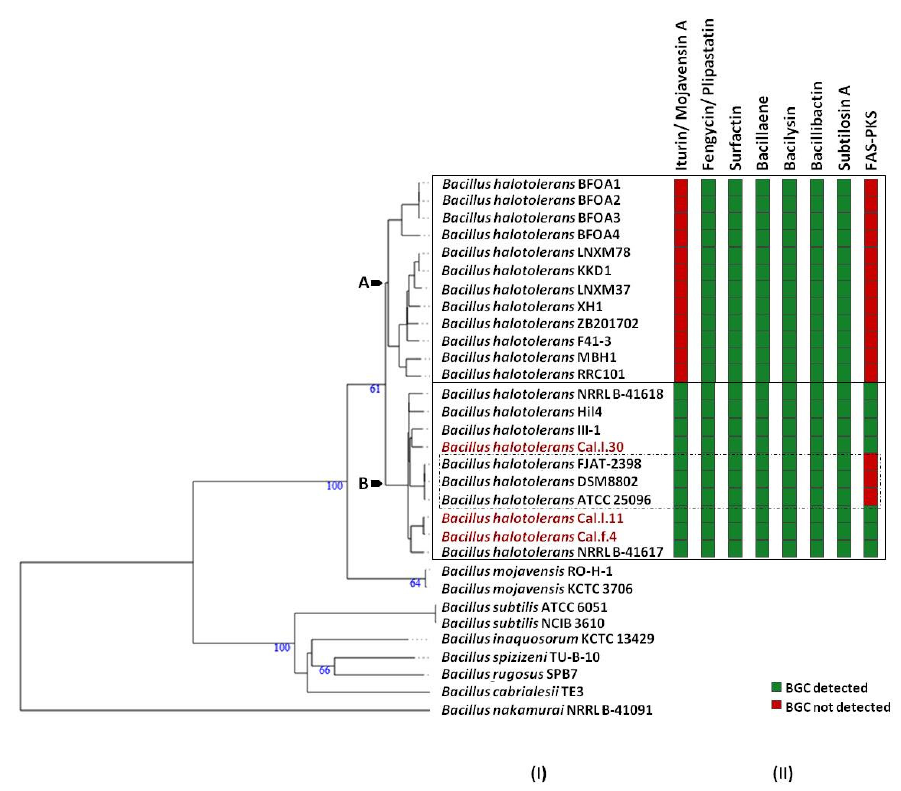
Figure 6. The secondary metabolic gene clusters evolution. ( I ) Whole genome phylogeny of B. halotolerans strains highlighting the endophytic bacterial strains Cal.l.30, Cal.f.4 and Cal.l.11. The numbers above branches are pseudo-bootstrap support values from 100 replications. Inferred clusters are for B. halotolerans strains harboring (Cluster B) or lacking (Cluster A) the iturin/ mojavensin A BGC. ( II ) Number and distribution heatmap of the secondary metabolite biosynthetic gene clusters (iturin/ mojavensin A, fengycin/ plipastatin, surfactin, bacillaene, bacilysin, bacillibactin, subtilosin A and FAS-PKS) detected (green) or not (red) among B. halotolerans strains. B. halotolerans strains Cal.l.30, Cal.l.11 and Cal.f.4 are highlighted in red.